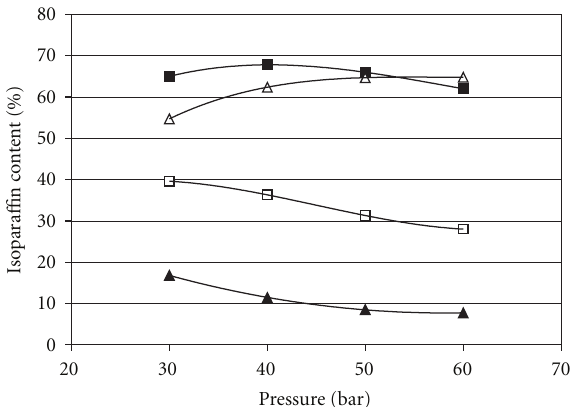
Figure 12: Total isopara ffi n content of the products as a function of pressure, and temperature; where: and Δ -380 ◦ C (LHSV = 1.0 h − 1 , H 2 / hydrocarbon volume ratio = 400 Nm 3 /m 3 ).